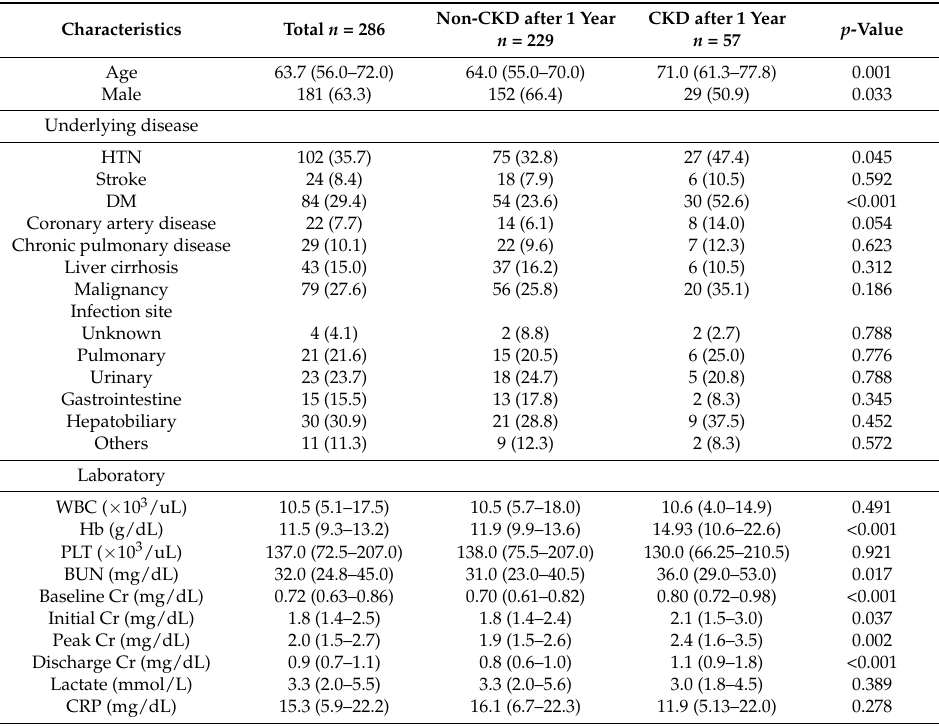
Table 1. Characteristics of